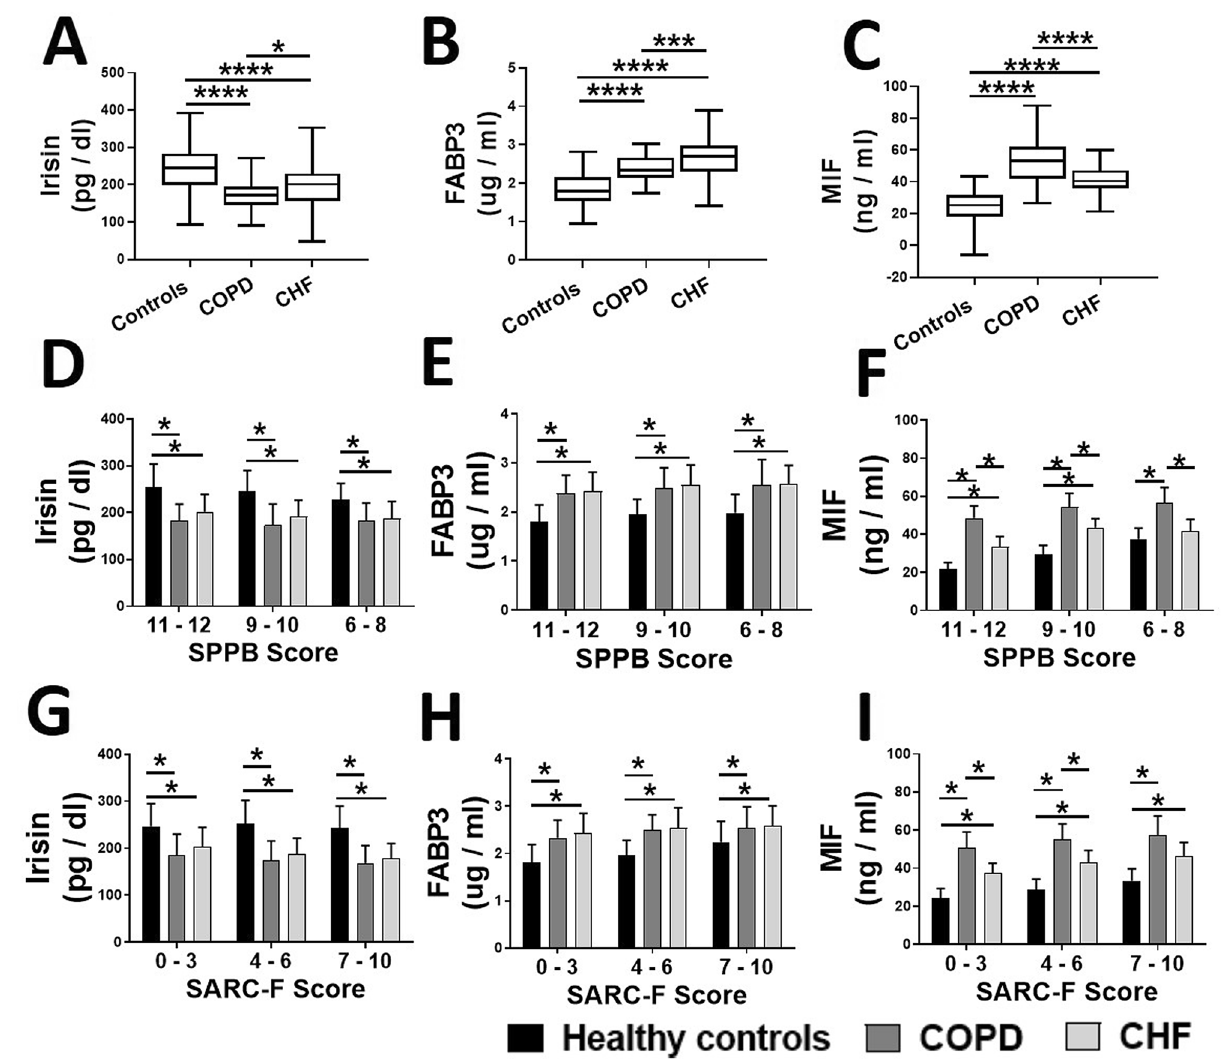
Figure 3. Comparison of circulating irisin ( A ), FABP3 ( B ) and MIF ( C ) levels in healthy controls (N = 87) and patients with COPD (N = 86) and CHF (N = 81). The biomarkers levels were generally higher in the participants with advanced sarcopenia based on SPPB ( D , E , and F ) and SARC-F ( G , H , and I ) scoring. Values are expressed as mean ± SD, one-way analysis of variance. * p <